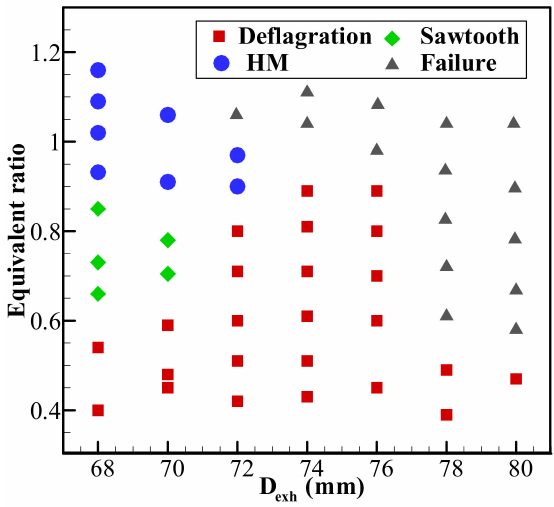
Figure 10. Operating range of combustion modes under the various diameter of the exhaust